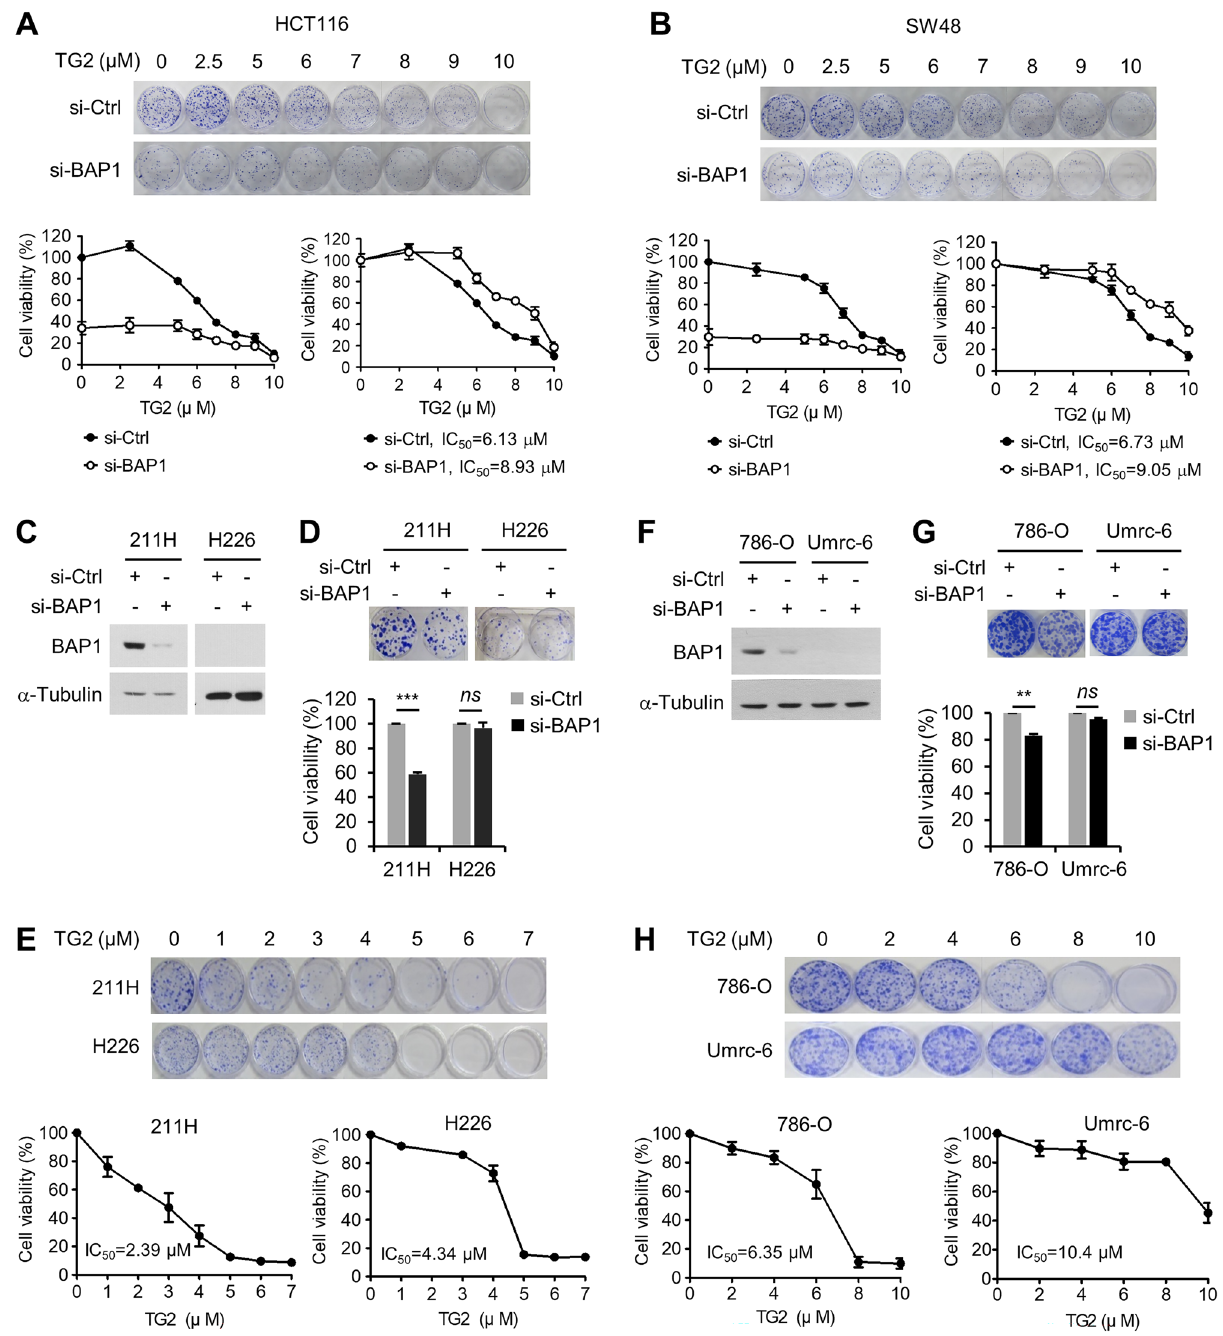
Figure 7. TG2-179-1 exerts cytotoxic activity against colon cancer cells by targeting BAP1. ( A , B ) After transfection with control or BAP1 siRNAs, HCT116 ( A ) and SW48 cells ( B ) were treated with increasing concentrations of TG2-179-1, and viability was evaluated by a colony formation assay. Representative results of the colony formation assay are shown (top). Relative viability was depicted graphically by setting the value for DMSO-treated (0 μM) si-Ctrl cells as 100 (lower left) or by setting each of the DMSO-treated si-Ctrl and si-BAP1 cell groups as 100 (lower right). The IC 50 values are shown. ( C ) After transfection of MSTO-211H and H226 mesothelioma cells with control or BAP1 siRNAs, BAP1 expression was analyzed by immunoblotting. ( D ) The viability of the cells transfected as described in ( C ) was evaluated by a colony formation assay. Representative results are shown, along with a summary graph. n = 3; error bars, mean ± s.d. values. ( E ) MSTO- 211H and H226 cells were treated with increasing concentrations of TG2-179-1, and viability was evaluated by a colony formation assay. Representative results are shown, along with a summary graph. n = 3; error bars, mean ± s.d. values. The IC 50 values are shown. ( F – H ) Results of similar experiments as in C-D with 786-O and Umrc-6 ccRCC cells. ( F ) Immunoblots for BAP1 depletion. ( G ) Results of the colony formation assay after BAP1 depletion. n = 3; error bars, mean ± s.d. values. ( H ) Results of the colony formation assay after TG2-179-1 treatment. n = 3; error bars, mean ± s.d. The IC 50 values are